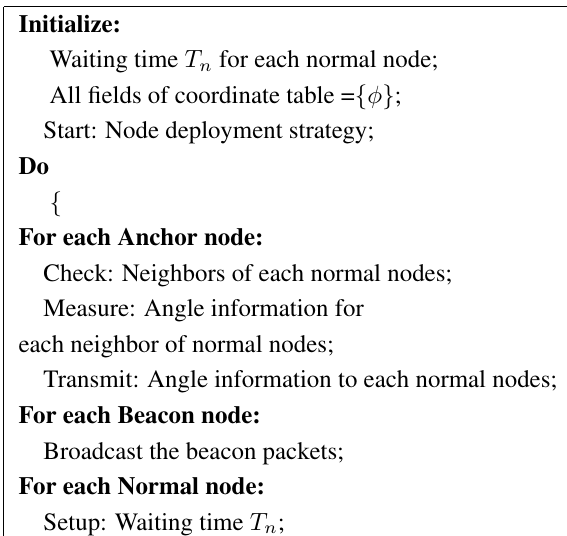
Table 2. Distributed Localization (DIL)